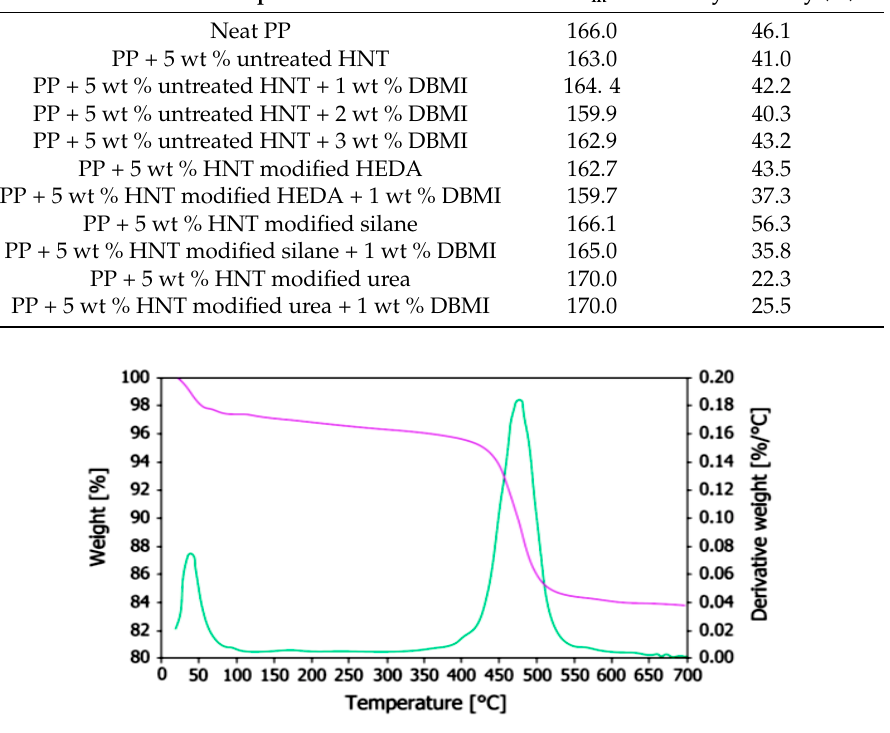
Figure 10. TGA curves of halloysite particles [84].